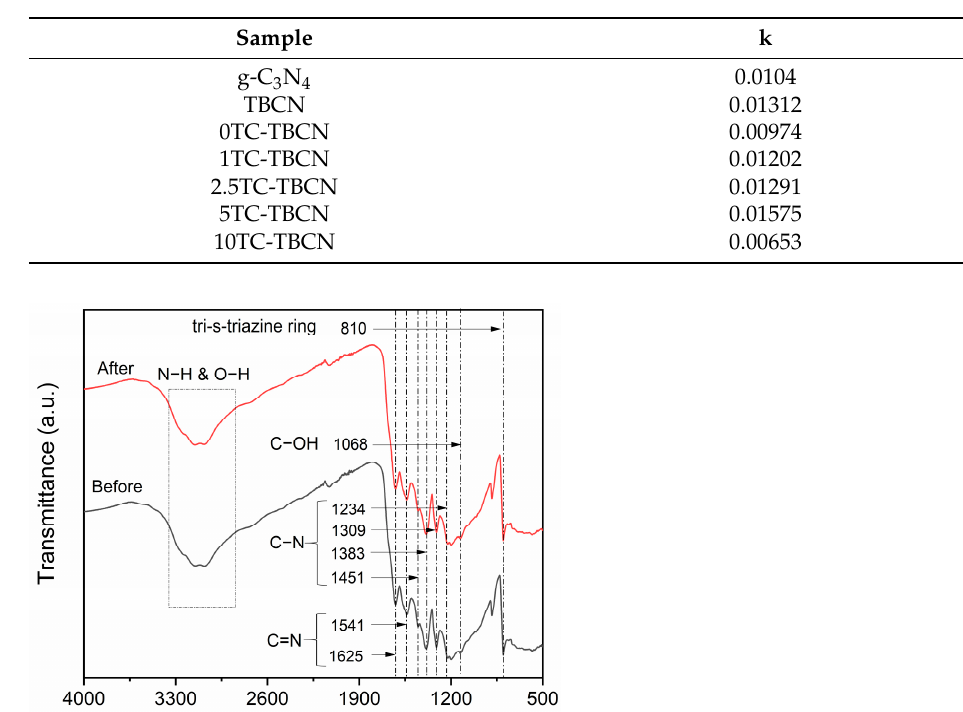
Figure 8. ( a ) Time profiles of the degradation of RhB and ( b ) the corresponding kinetic fitting curves with irradiation time; ( c ) photocatalytic stability and ( d ) photodegradation of RhB over 5TC-TBCN in the presence of different reactive species scavengers. [Catalyst] = 0.5 g/L; [RhB] 0 = 10 ppm. Table 2. Degradation rate constant (k) values of RhB for different photocatalysts.